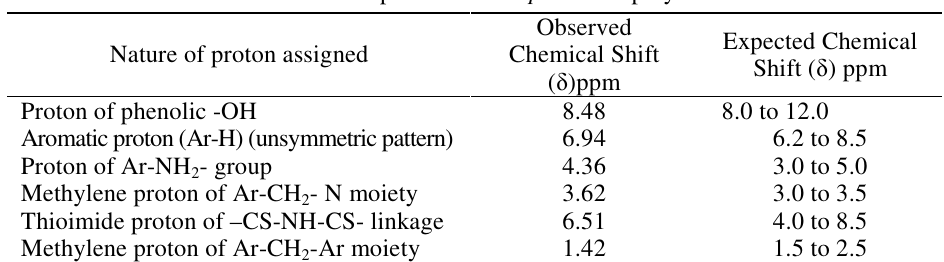
Figure 3. NMR spectra of p -CDF terpolymer resin Table 2. 1 H-NMR spectral data of p -CDF terpolymer